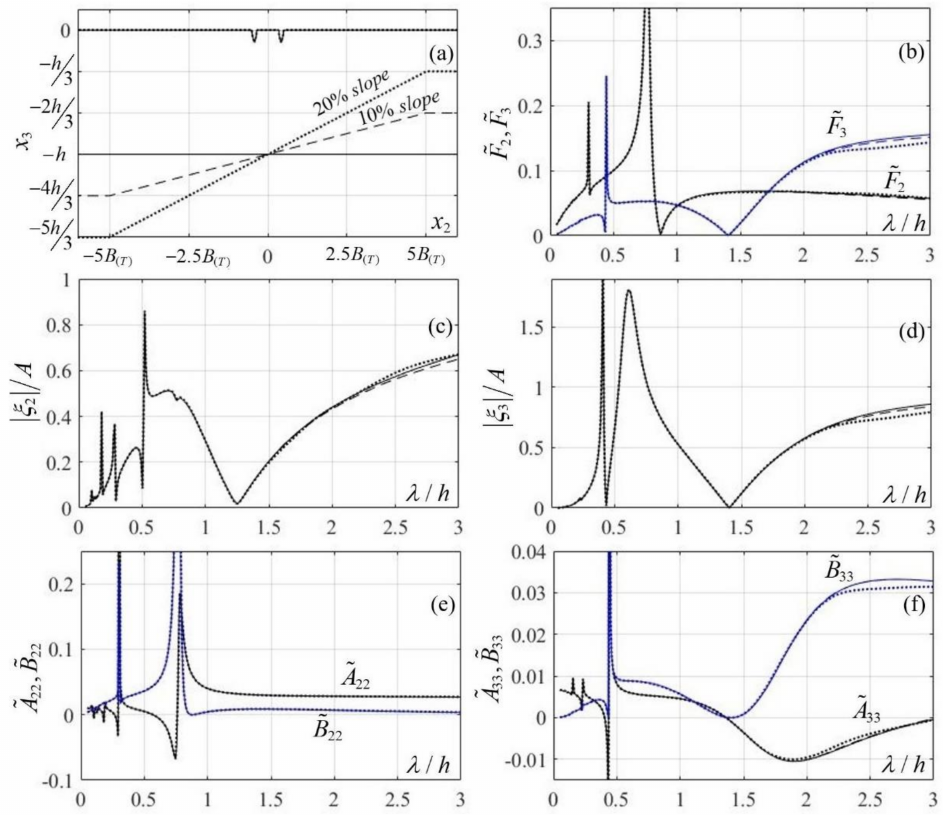
Figure 6. ( a ) Floating body and domains of transmission ( B ( T ) / h = 2/3, B ( H ) / h = T / h = 1/10). ( b ) Hydrodynamic forces (cid:101) F k , k = 2,3. ( c , d ) RAOs in sway and heave motions, respectively. ( e , f ) Hydrodynamic coefficients A 22 , B 22 and A 33 , B 33 , respectively. All quantities were plotted vs. the non-dimensional wavelength λ / h , where h denotes the average water